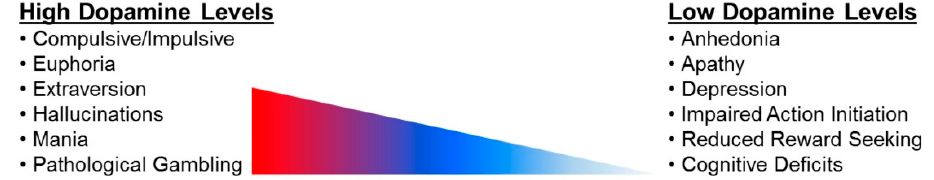
Figure 3. Overview of behaviors characteristic of a hyperdopaminergic versus hypodopaminergic state.